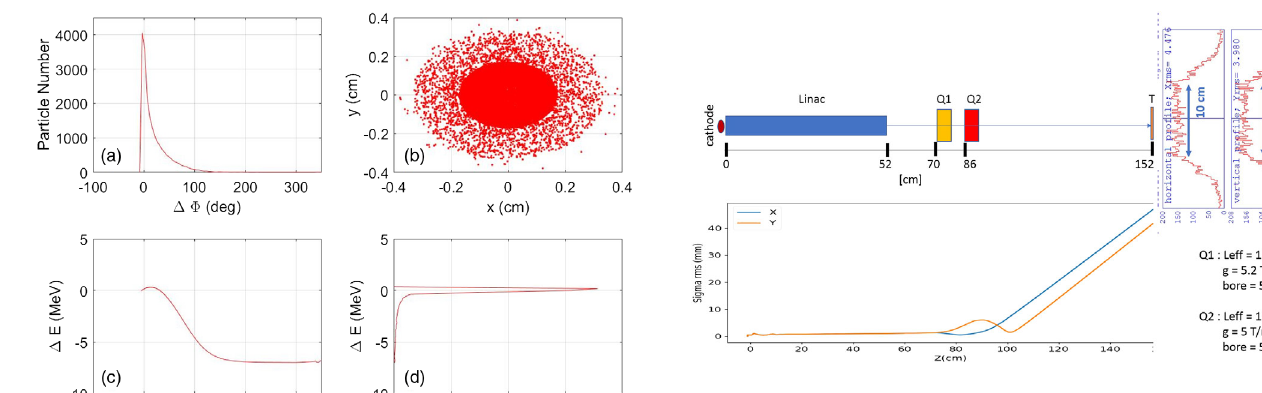
FIG. 11. Sketch of the accelerator system (e-gun and linac) with the quadrupole magnets (Q1 and Q2). The electron beam trans- verse distribution at 80 cm from the linac exit is also shown.